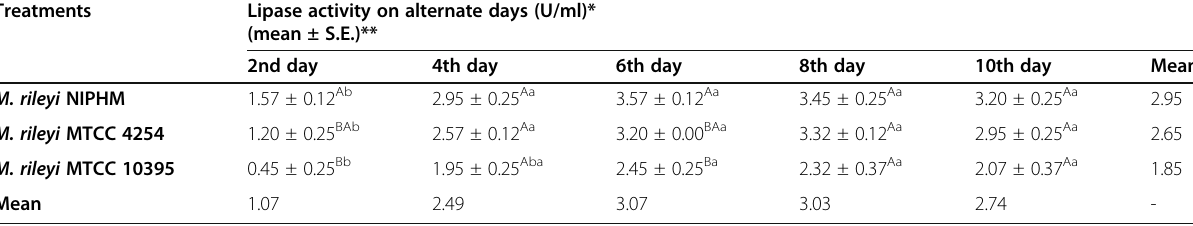
Table 4 Lipase activity of Metarhizium rileyi isolates on different days after inoculation Treatments